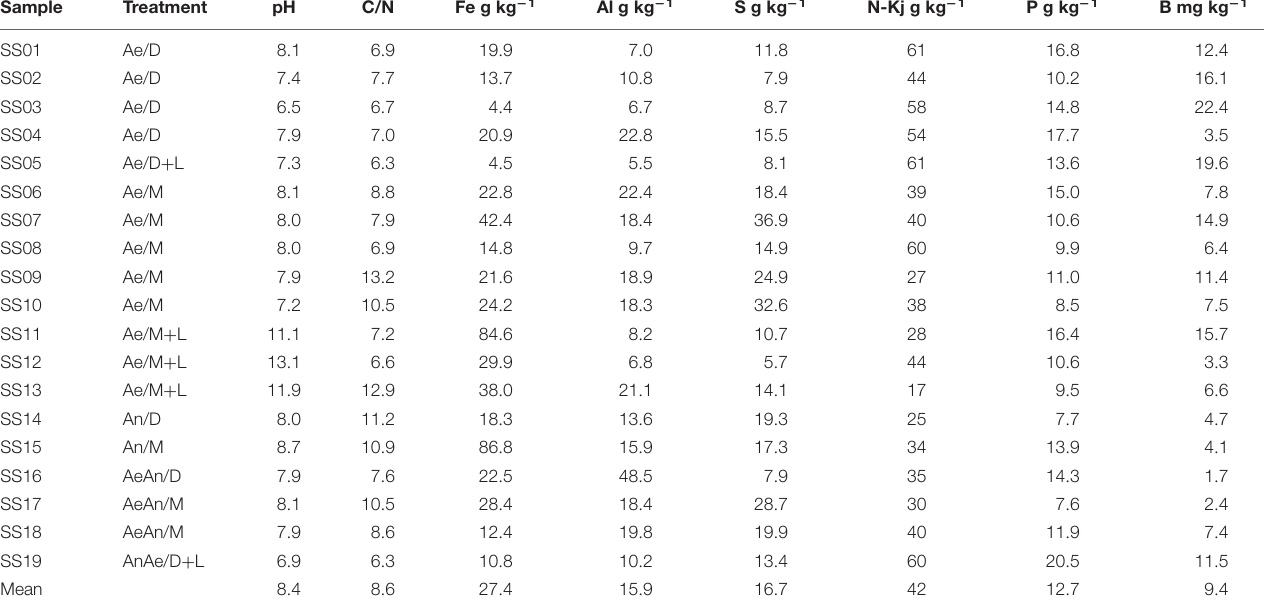
TABLE 1 | Sewage sludges sources and treatments as well as main chemical attributes.